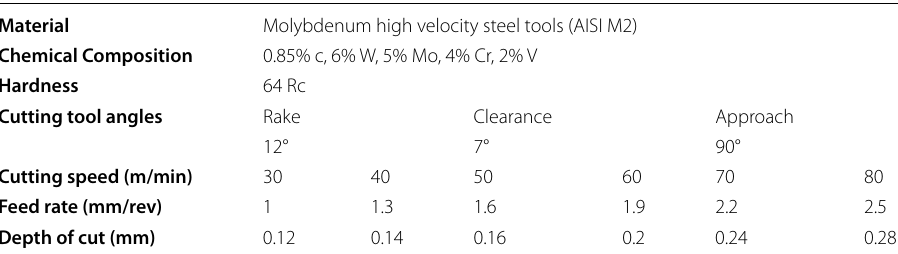
Table 3 Cutting tool